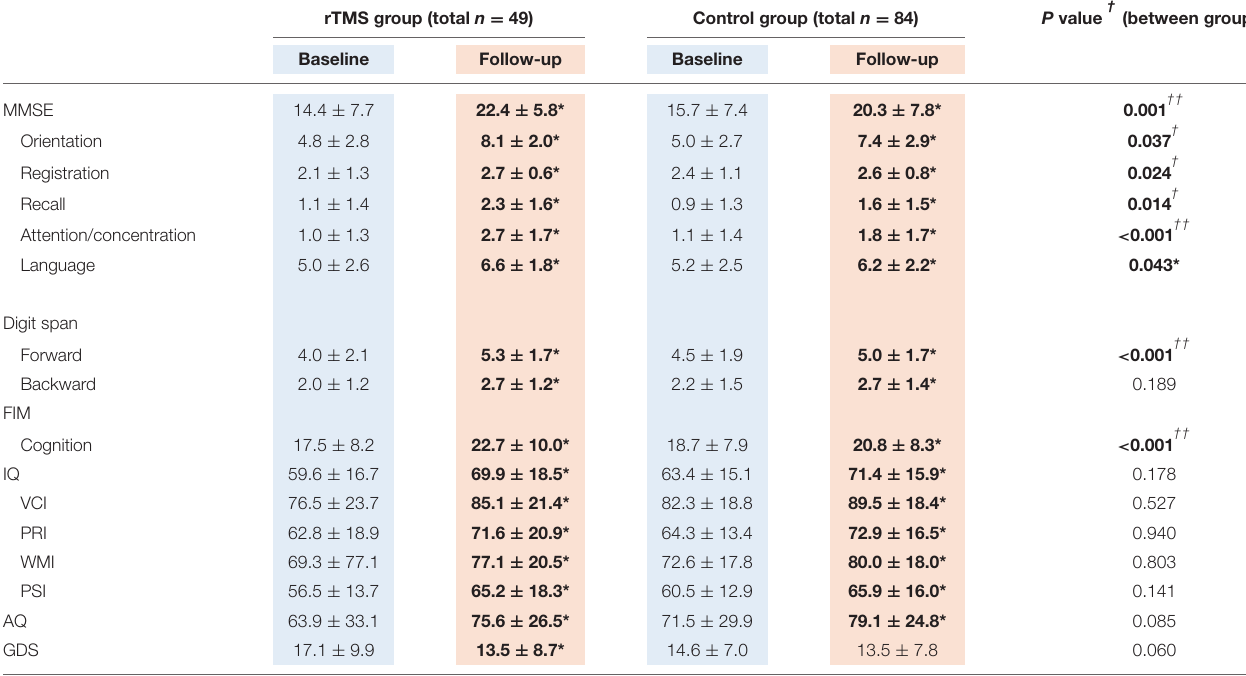
TABLE 2 | Comparison of rehabilitation outcomes between rTMS and control groups (total subjects, N =